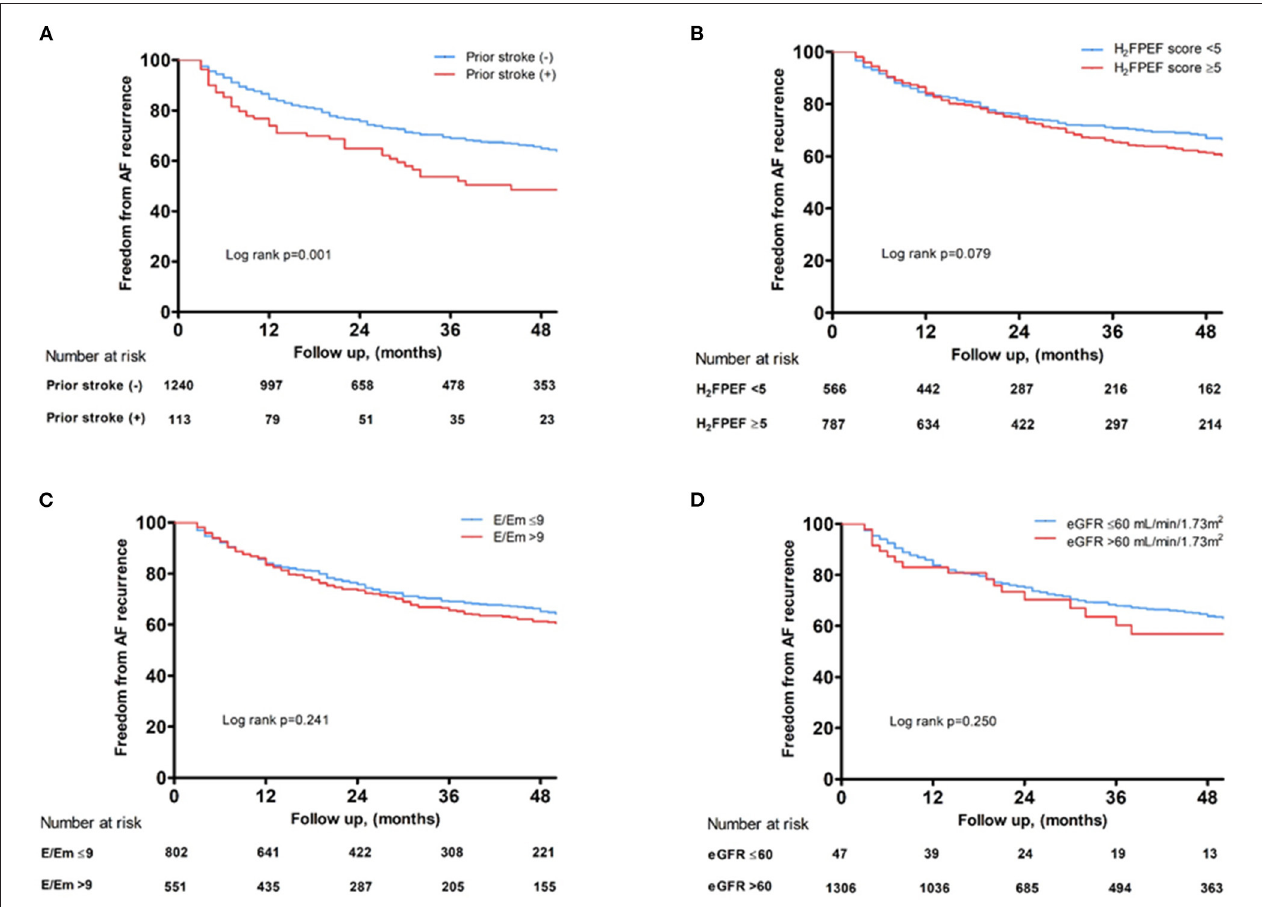
FIGURE 4 | Kaplan–Meier curves showing the rate of freedom from AF recurrence after AFCA depending on a prior ISs (A) , baseline H 2 FPEF score (B) , E/Em (C) , and renal function (D) . AF, atrial fibrillation; AFCA, atrial fibrillation catheter ablation; E/Em, the ratio of the early diastolic mitral inflow velocity (E) to the early diastolic mitral annular velocity (Em); IS, ischemic